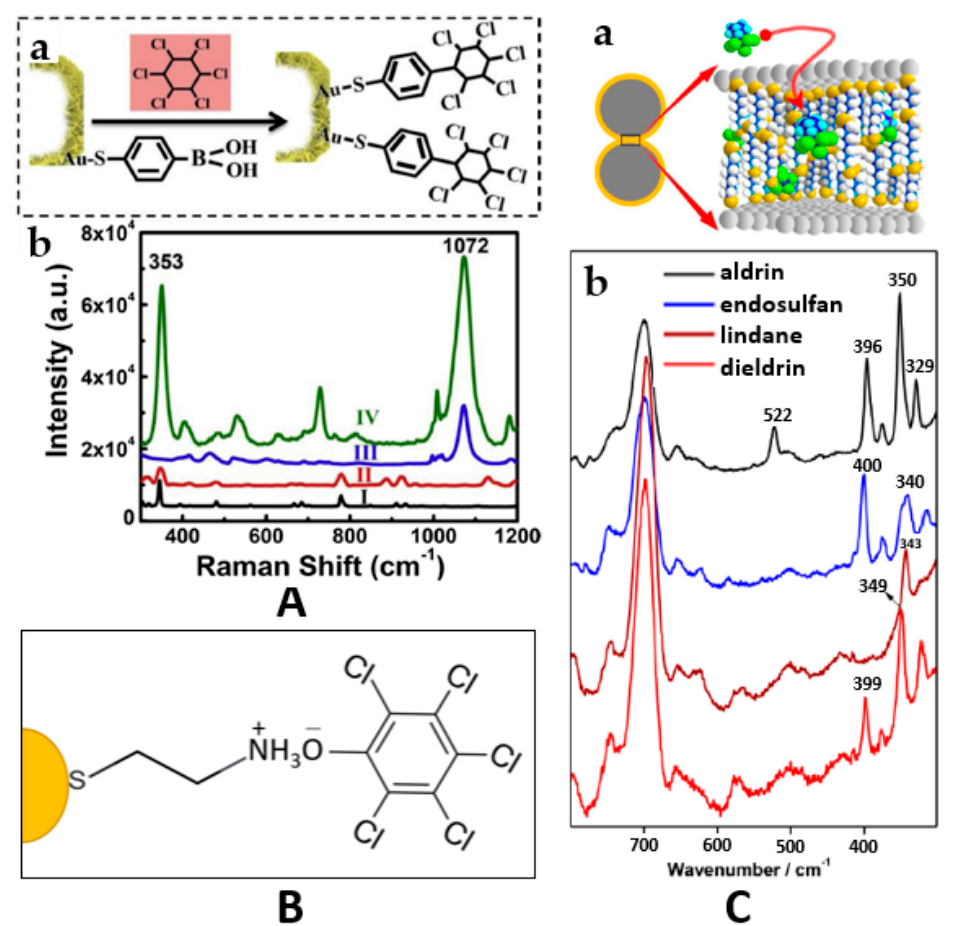
Figure 3. Strategies for increasing the affinity toward the analyte. ( A ) ( a ) The Suzuki cross coupling reaction occurred between HCH and 4-MPBA via covalent linkage (C–C) on the modified substrate. ( b ) The Raman spectra of solid HCH (curve I), the SERS spectra of γ -HCH (10 − 6 M) obtained on the naked ANHC substrate (curve II), 4-MPBA modified ANHC substrate (curve III), 4-MPBA modified ANHC substrate immersed into 10 − 6 M HCH solution (curve IV). Reproduced with permission of [53]. Copyright Elsevier, 2019. ( B ) Schematic representation of the mechanism of sensing PCP using cysteamine modified substrates. ( C ) ( a ) Scheme displaying the pesticide hosting (in this case, for aldrin) in the dithiol layer organized in interparticle gaps; ( b ) SERS spectra of the analyzed pesticides (10 − 5 M) on DT8-functionalized AgNPs, showing the C–Cl stretching bands of the fingerprint region (300–400 cm − 1 ) and the C–S stretching bands of DT8 in the deduced multilayer highly ordered conformation employed as the reference band for quantitative analysis. Reproduced with permission of [23]. Copyright American Chemical Society,